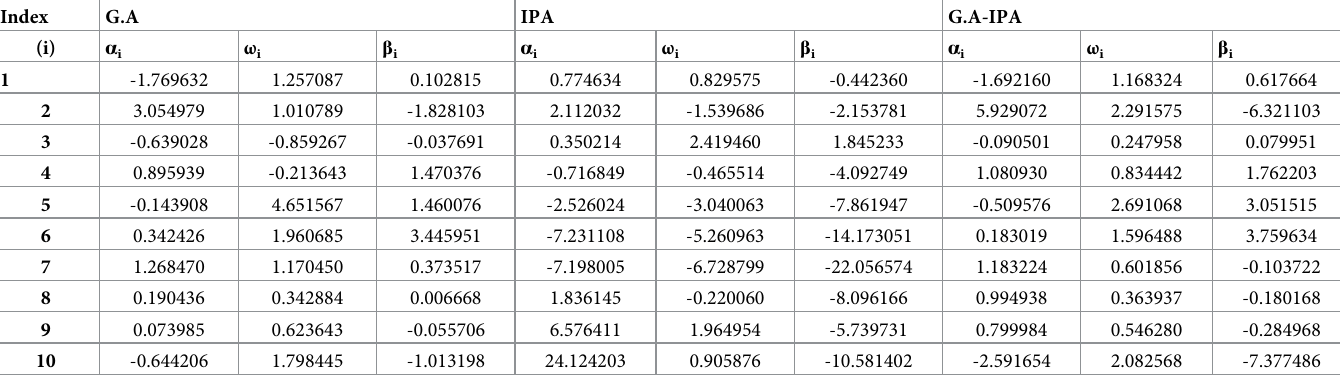
Table 3. Unknown parameters achieved by GA, IPA and GA-IPA for δ =